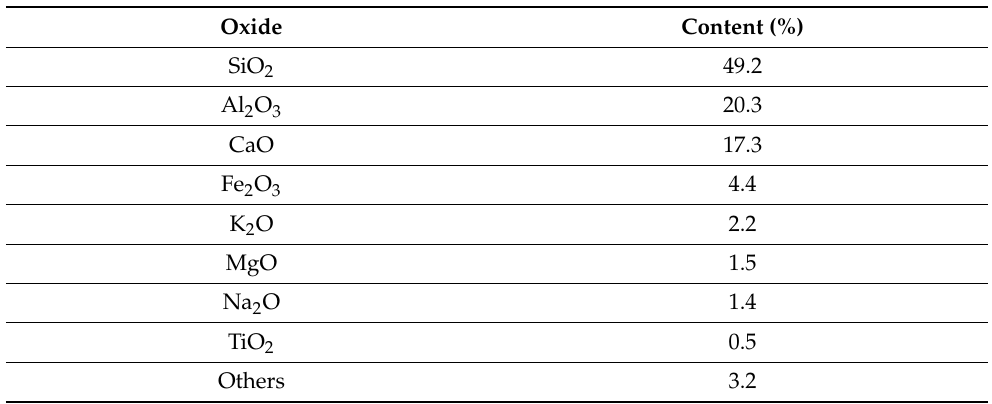
Table 4. Chemical composition of